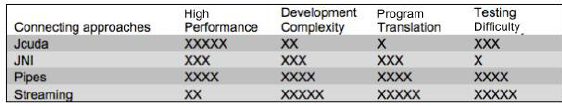
Table 1. Overall Comparison of Four